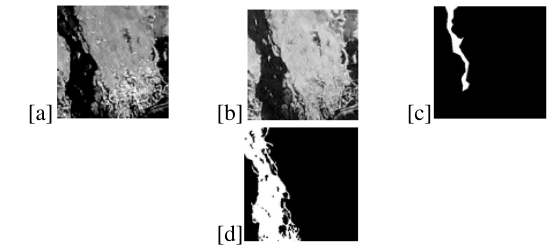
Figure 1. Visual example of SAR image and corresponding label mask in the dataset: (a) Sentinal-1 VV (b) Sentinal-1 VH (c) Water body data and (d) Flood label